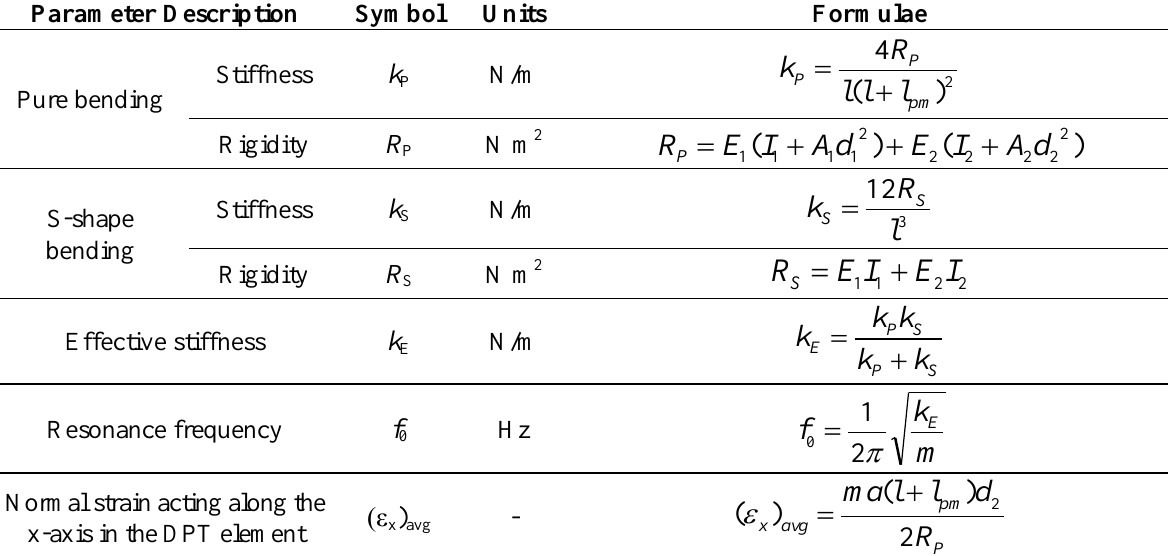
Table 2. The governing equations of the vibration energy